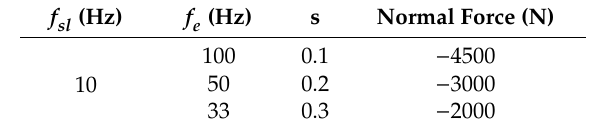
Table 1. Correlation between elements in fixed slip-frequency control.